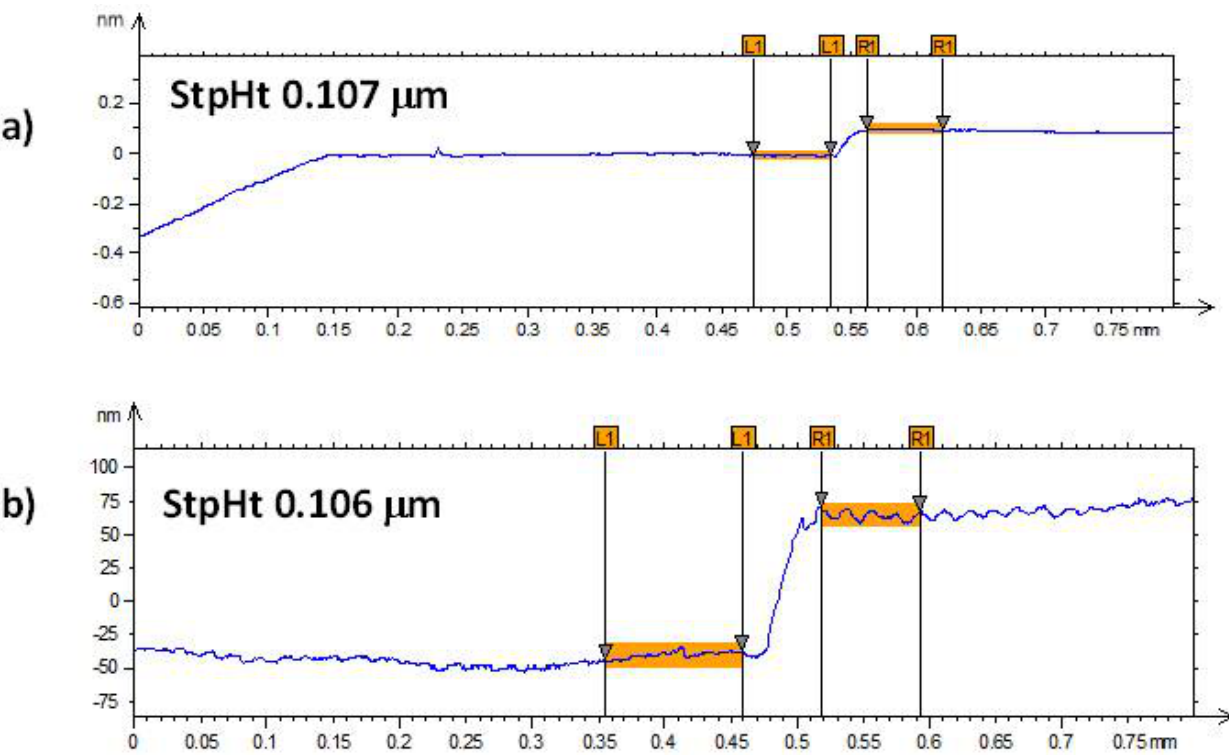
Figure 3. ( a , b ) Profilometry measurements at two different points of thin films of BFO on SrTiO 3 .